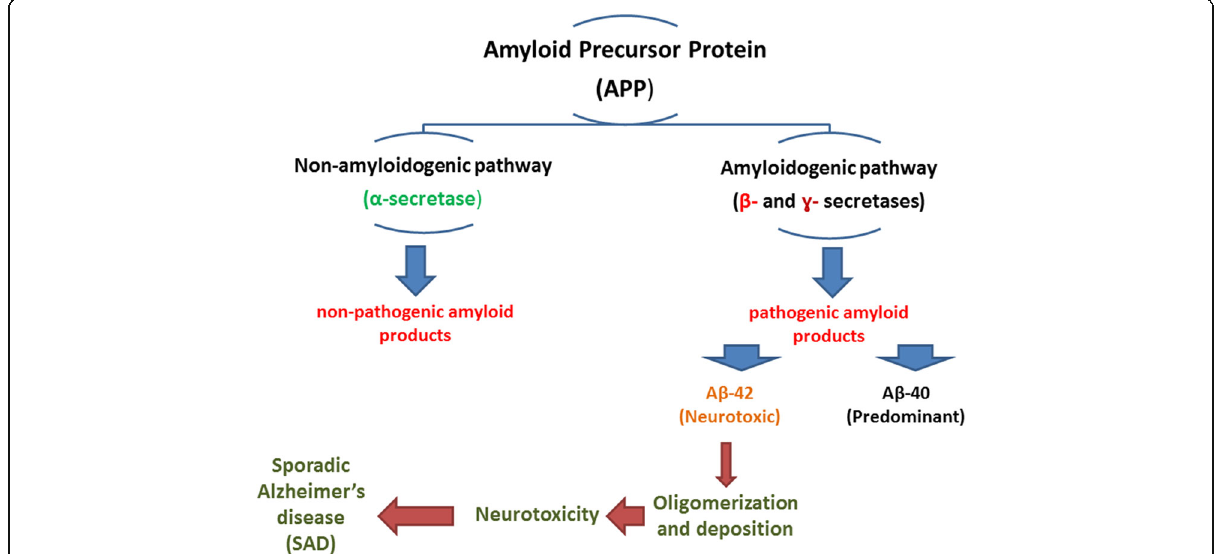
Fig. 1 The amyloidogenic and non-amyloidogenic pathways of the amyloid precursor protein (APP): APP is enzymaticaly hydrolyzed by either α - or β -secretase. The non-amyloidogenic pathway, implicating α -secretase, leads to the extracellular release of non-pathogenic products. The amyloidogenic pathway, involving β -secretase (BACE1) and ɣ -secretase, results in the generation of amyloid products of varying length (A β -40 and A β -42), accumulation of these neurotoxic proteins could lead to neurodegenration and might be the main cause of